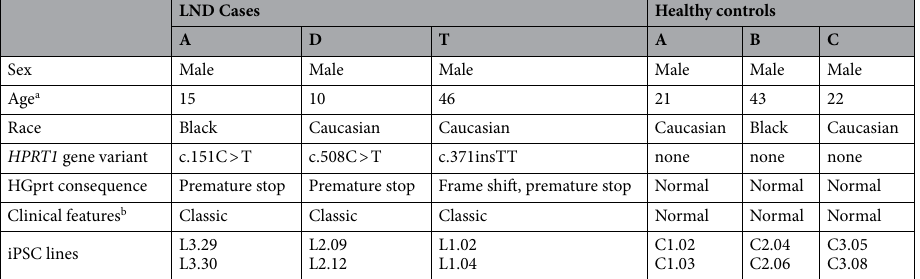
Table 1. Subject characteristics. a Age relates to subject age at skin biopsy. b Clinical features of classic LND include motor dysfunction resembling cerebral palsy, cognitive impairment, self-injurious behavior, and overproduction of uric